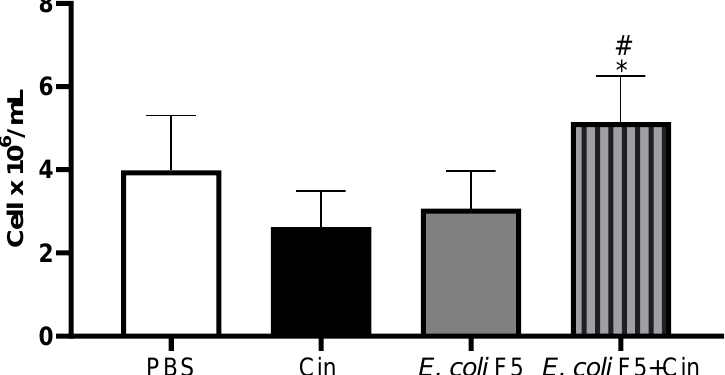
Figure 6. Total bone marrow cell counts from animals infected with E. coli F5 and cinnamaldehyde treatment. Ten hours after peritoneal inoculation of E. coli F5, bone marrow cells were obtained. The cells were stained with 0.05% violet crystal in 30% acetic acid and counted under a light microscope. The results represent the mean ± S.D. of 6 animals/group. * p < 0.05 as compared with the E. coli F5 group and # p < 0.01 as compared to the CIN group.